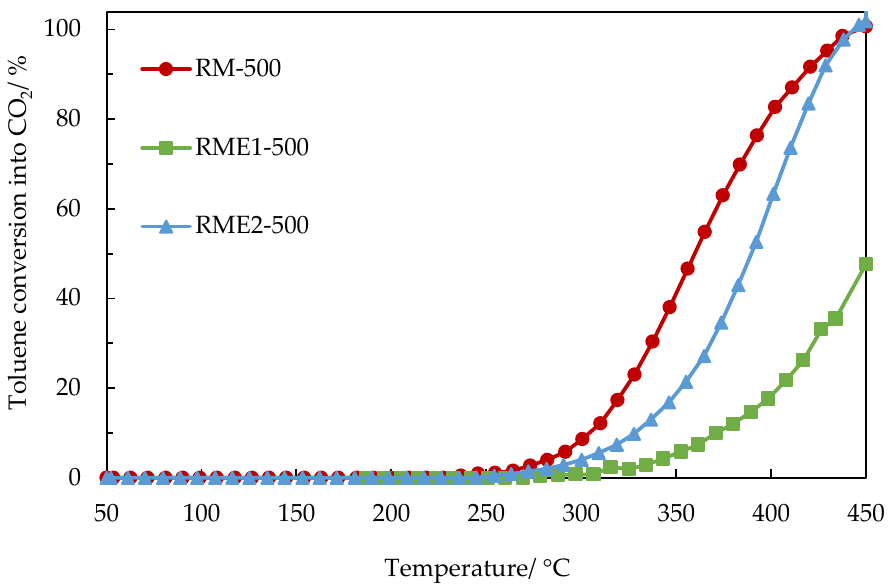
Figure 6. Toluene conversion to CO 2 as a function of the temperature in the presence of the un- modified calcined red mud (RM-500) and the evaporated catalysts (RME1-500 and RME2-500).